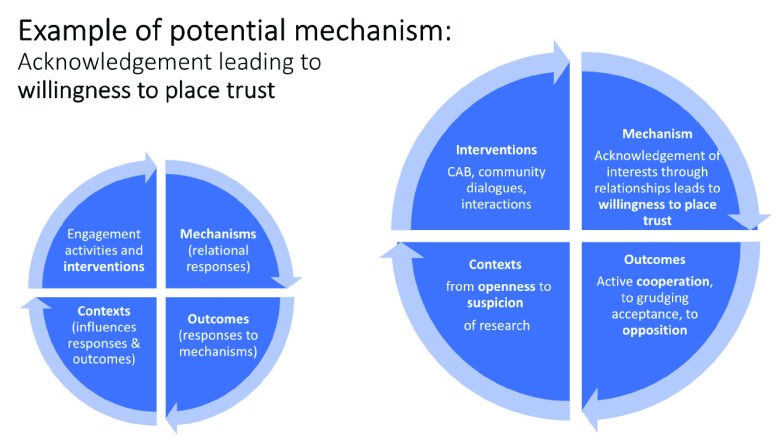
Example mechanism.